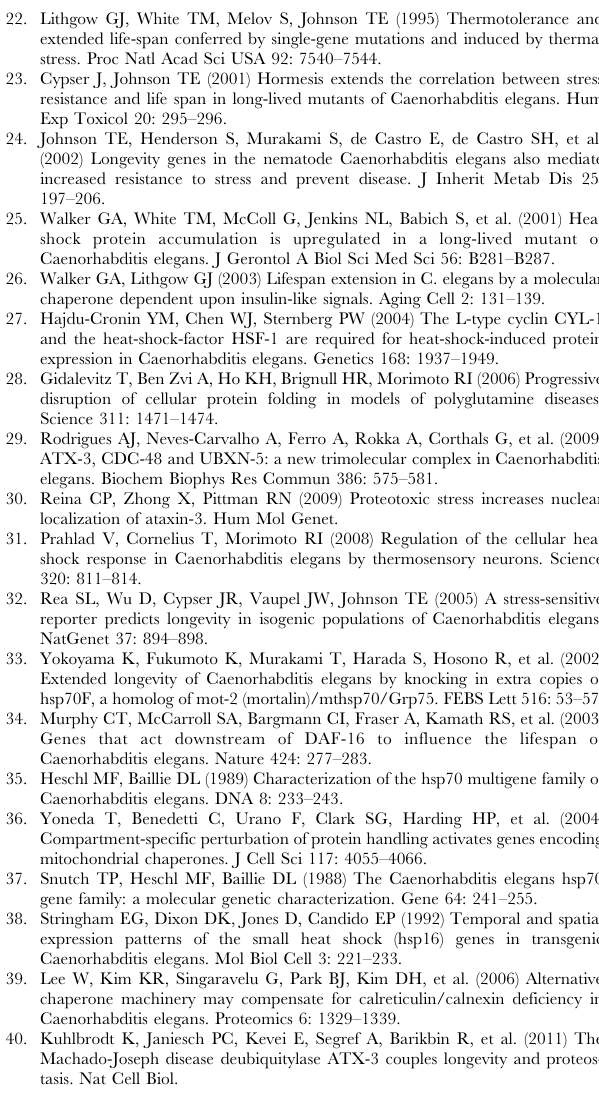
Figure S1 DAF-16 targets sod-3 and mtl-1 are activated differentially in atx-3 mutants both at 20 6 C (A) and 25 6 C (B). At 20 u C, sod-3 is up-regulated 90 minutes after heat